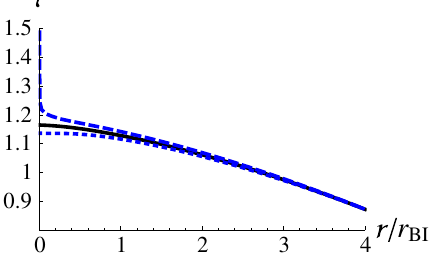
Fig. 4 The maximal infalling proper time τ( r ) for ε = 0 is shown as a function of r / r BI . The dashed, dotted and the solid curves correspond to δ = 0 . 01, δ = − 0 . 01 and δ = 0 (GR) at x i = 10,